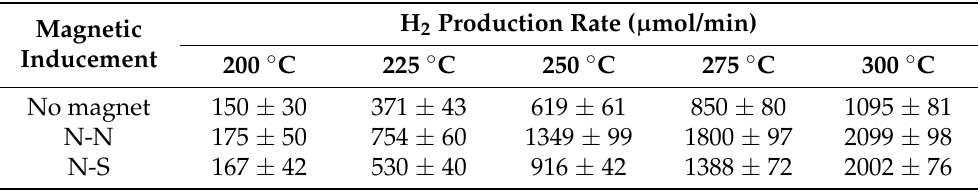
Table 1. H 2 production rate of Cu-Zn catalysts (no magnet) on CeO 2 -Al 2 O 3 supports prepared with and without magnetic inducement. The magnetic environments are between north–north magnetic poles (N-N) and between north–south magnetic poles